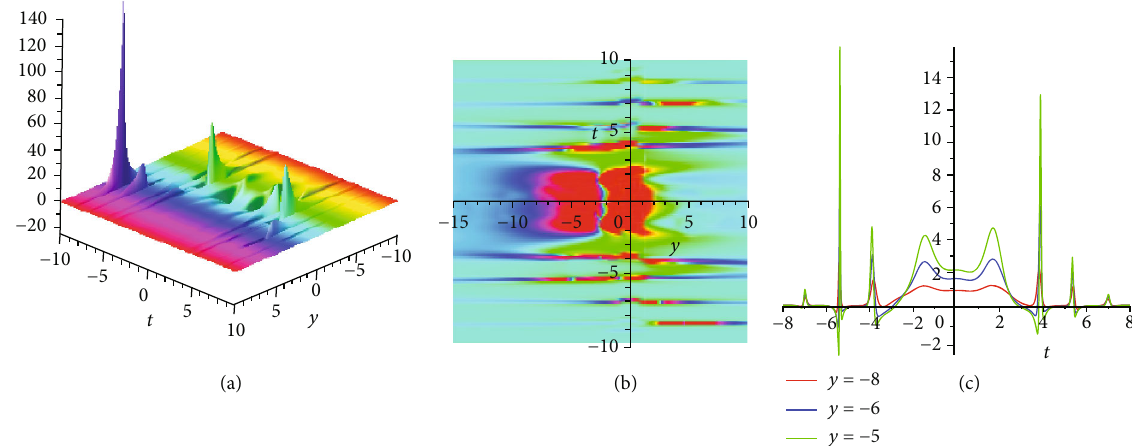
Figure 11: Plots of interaction with two lumps